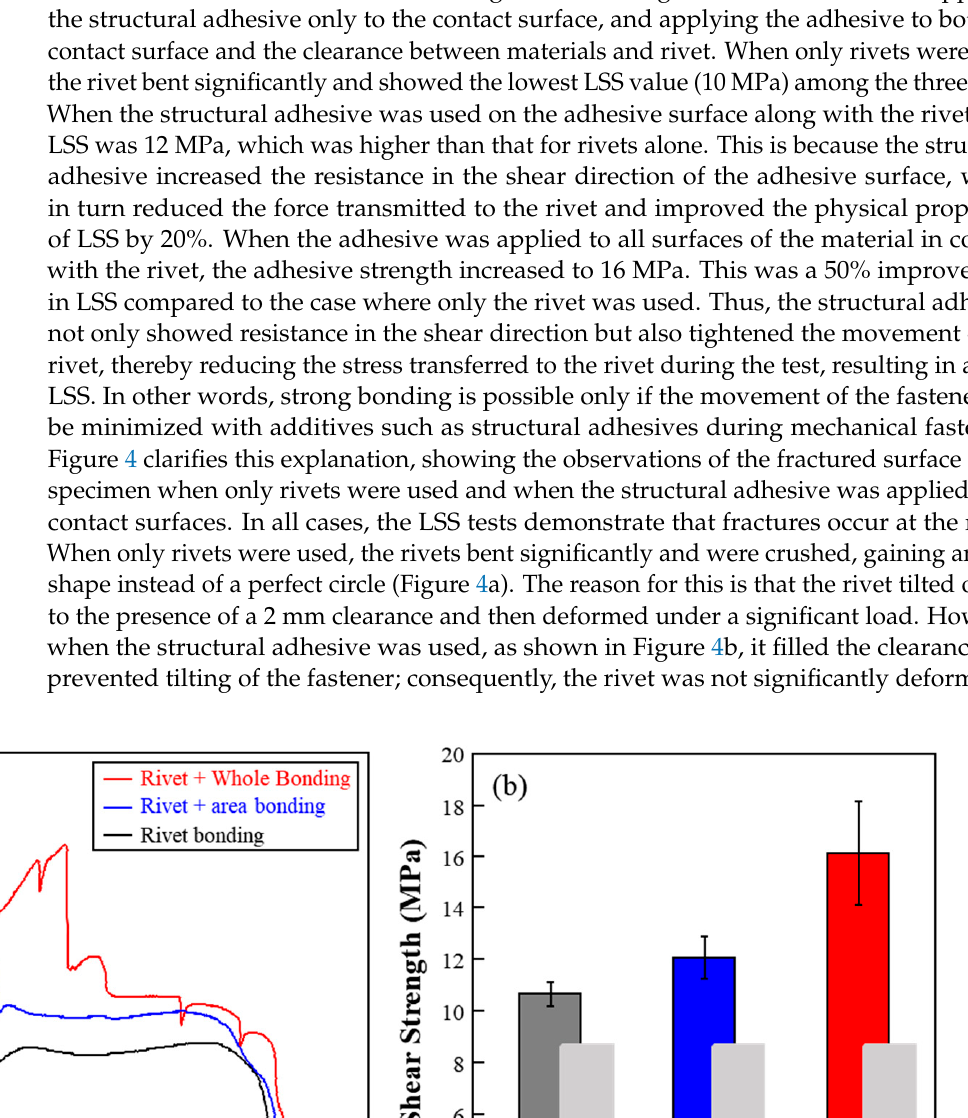
( b ) Figure 4. Fractured surface of LSS specimens depending on whether or not adhesive was used: ( a ) rivet only and ( b ) both rivet and adhesive . 3.1.2. Bolting Figure 5 shows the results of evaluating the adhesive load according to the use of washer and structural adhesive when CFRP and steel were bonded by bolting. Type 1 denotes the case in which only bolts and nuts were used. The maximum lap shear load was approximately 2400 N, which was relatively low compared with other cases. How- ever, the maximum lap shear load signi fi cantly increased to approximately 4200 N when the washer was used for both the bolt and nut (Type 4). Since the inclination of the bolt was constant when no adhesive was used, the strength improved because the de fl ection of the bolt decreased under the in fl uence of the washer. Unlike riveting, in all cases of bolting, the adhesive strength was determined by the fracture of the steel. Therefore, the reduction in the de fl ection of the bolt prevented bending of the steel and minimized the pre-tension on the outer surface of the steel that resulted from bending; consequently, the bonding strength increased. When the washer was used on only one side as in Types 2 and 3, unlike the case in which the bolt and nut were used on both sides, the e ff ect of preventing the bolt from bending reduced; consequently, the maximum lap shear load was lower than that when the washer was used on both sides. In particular, when a washer was used only on the bolt side, it had a signi fi cantly lower strength than when a washer